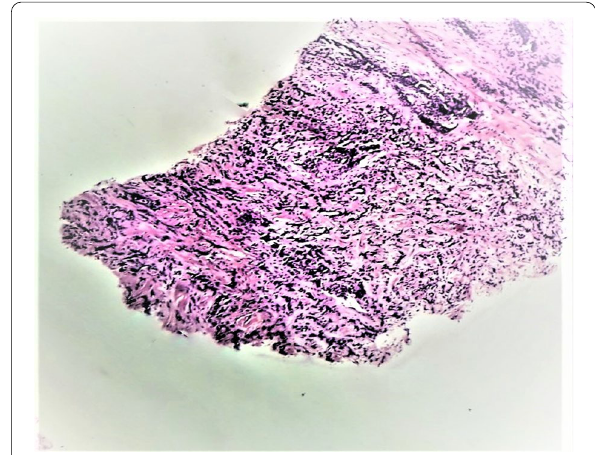
Fig. 3 Microscopic appearance of the core biopsy of the prostate sarcomatoid carcinoma (H&E)